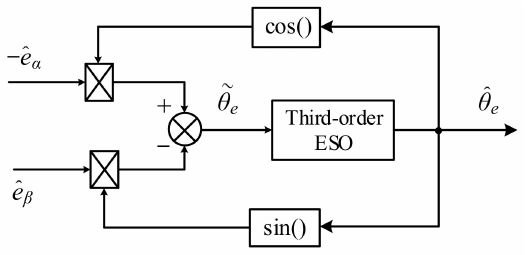
Figure 5. Estimation of rotor position information based on the third-order ESO.